Question: Does the plotted quantity increase or decrease?
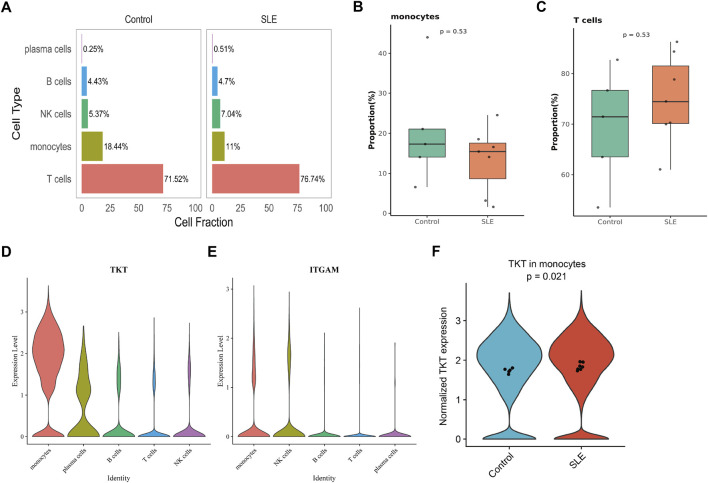
Answer: increasing